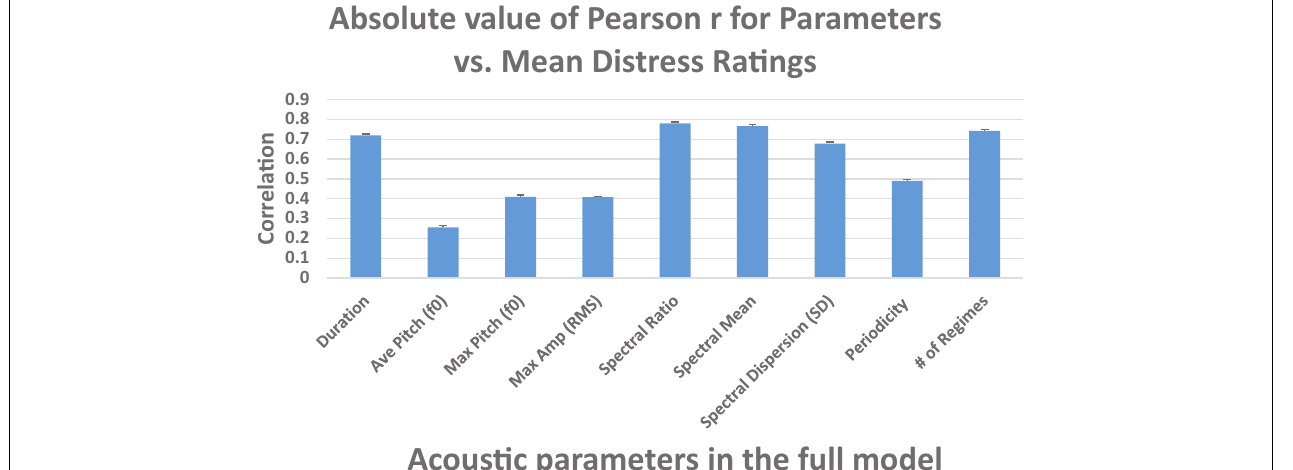
FIGURE 2 | Pearson correlations between each of the nine acoustic parameters selected for the full model and the mean perception ratings of distress level. Average Pitch (f 0 mean) represents mean fundamental frequency within each utterance. Max pitch represents the maximum f 0 within each utterance. Max amplitude (peak of the root-mean-square amplitude) represents maximum amplitude (in volts) across each utterance. Spectral ratio represents the ratio for each utterance of spectral energy below 2 kHz to the energy above 2 kHz in the regime segment with the minimum ratio. Spectral mean represents the maximum mean of spectral concentration (long-term spectral average) in kHz across the regime segments in each utterance. Spectral dispersion (SD) represents the maximum standard deviation of spectral concentration in kHz across the regime segments in each utterance. Periodicity represents the minimum cepstral peak prominence in dB across the regime segments in each utterance, a measure of periodicity. Number of regimes represents the number of regime segments within each utterance. Error bars = ± 1 SEM.